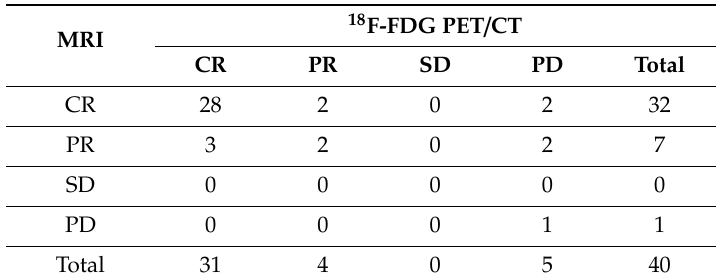
Table 2. Concordance between MRI and FDG-PET / CT after